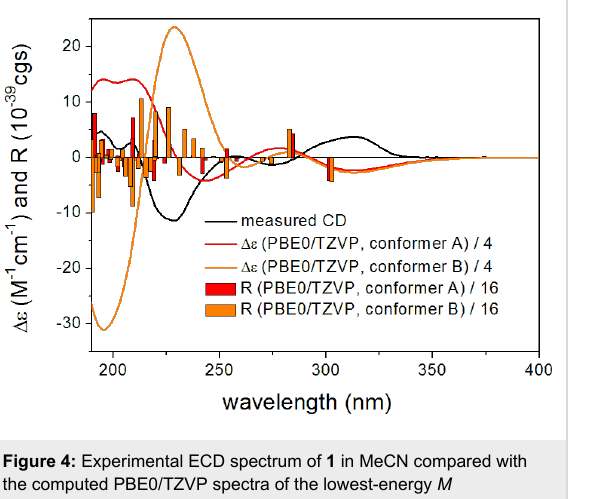
Figure 4: Experimental ECD spectrum of 1 in MeCN compared with the computed PBE0/TZVP spectra of the lowest-energy M ( ω C12 − C13 − C3’ − C9’ = –46.1°, conformer A) and P ( ω C12 − C13 − C3’ − C9’ = 133.4°, conformer B) helicity B3LYP/6-31G(d) conformers of (2 R ,3 R )- 1 . Bars represent the rotational strength values of the two conformers.